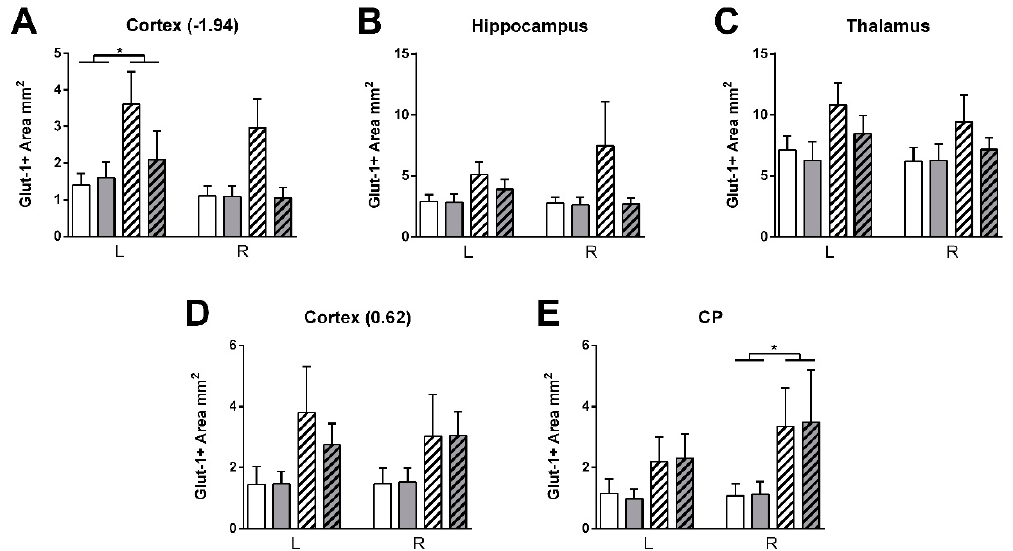
Figure 16. Immunohistochemical stainings for GLUT-1 in brains of HT and control fed mice 35 days after surgery. ( A – E ) GLUT-1 + -area was increased in stroke mice compared to sham mice in left cortex (bregma − 1.94: p < 0.046) and right caudate putamen ( p < 0.043). Values represent mean ± SEM. * p < 0.05.